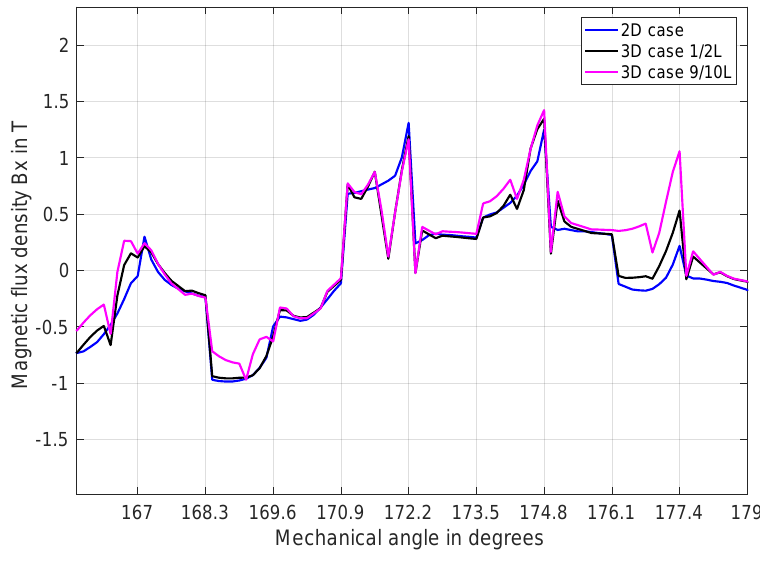
Figure 5. Comparison of B x ( r = 52.5 mm, angle = 167–180 ◦ ) between 2D and 3D simulations (iron